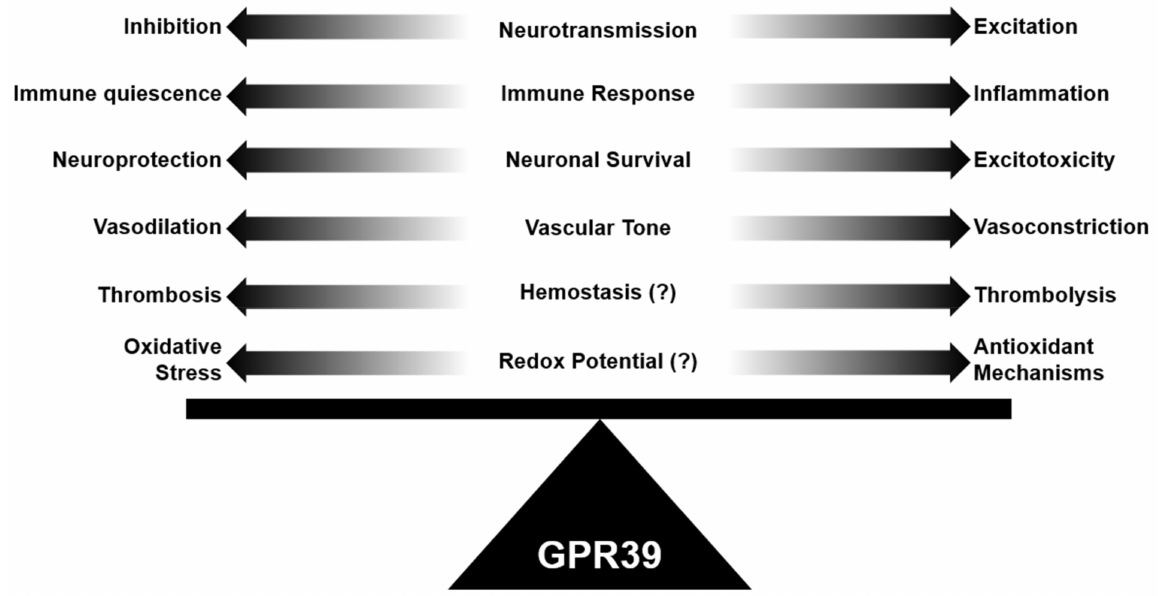
Figure 3. GPR39 is implicated in neurovascular and neuropsychiatric homeostasis. GPR39 plays a role in balancing neurotransmission, immune response, neuronal cell survival, vascular tone, and redox potential, suggesting it is uniquely positioned to promote homeostasis in the neurovascular and neuropsychiatric system. Disruption of GPR39 function may lead to dyshomeostasis and